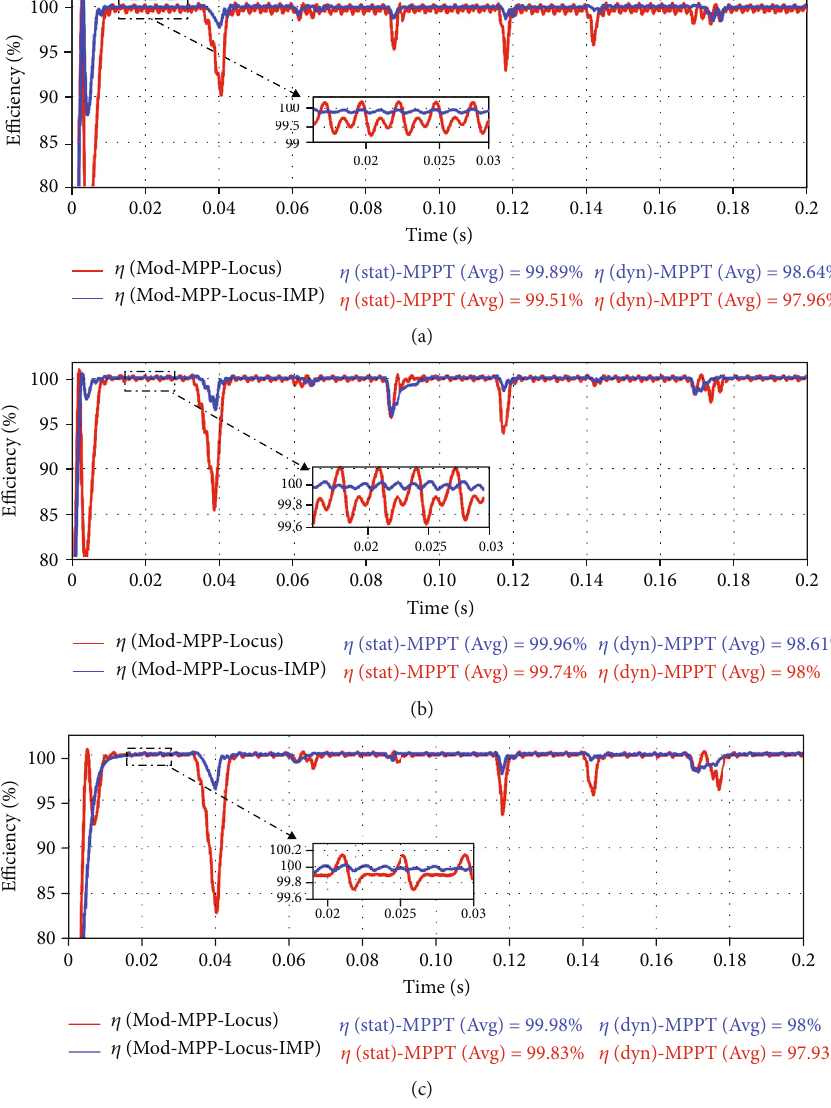
Figure 28: E ffi ciency pro fi le comparison between the Mod-MPP-Locus MPPT method and the improved Mod-MPP-Locus MPPT method under the scenario of temperature variation with a normal solar radiation (a) 1000W/m 2 , (b) 800W/m 2 , and (c) 600W/m 2